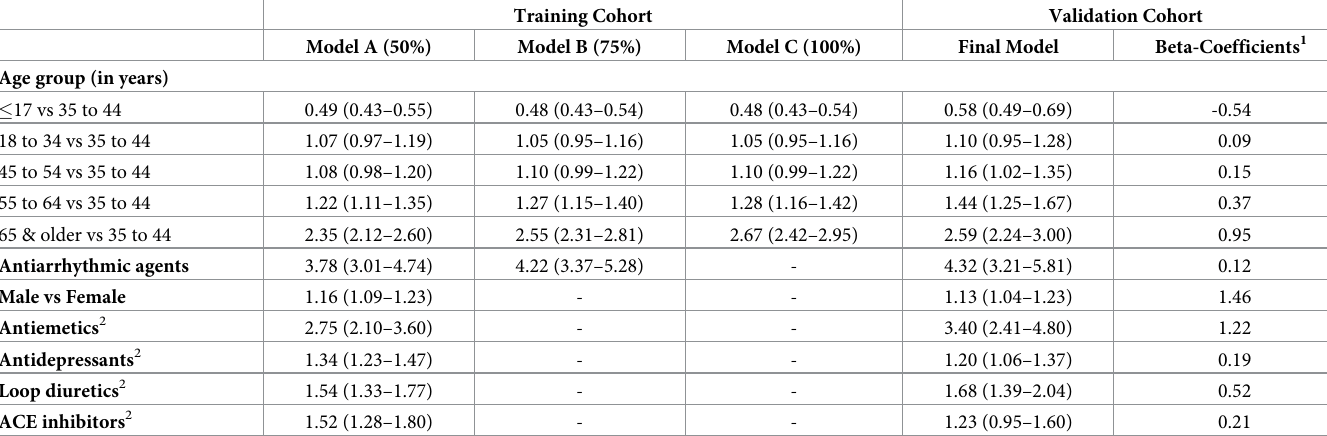
Table 5. Logistic regression model of predictors of cardiac events among episodes of azithromycin therapy—Model